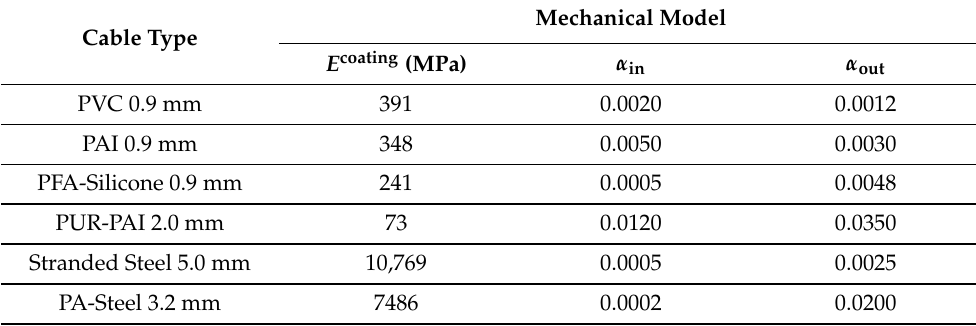
Table 2. Parameters used in the mechanical